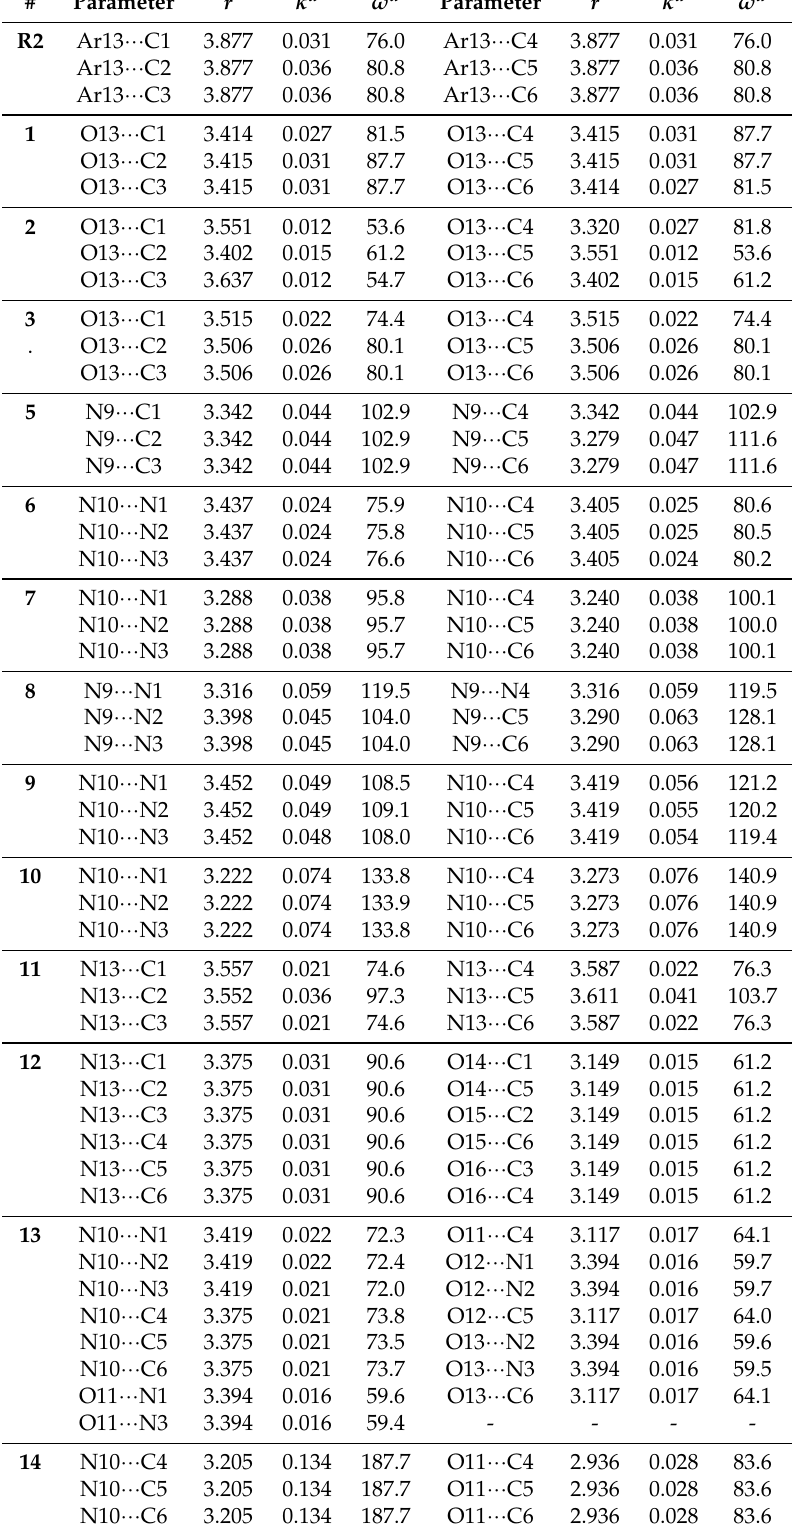
Table 5. Summary of LVM data: r , k a , and ω a for secondary bonding interactions SBI not including hydrogen atoms, for 1–14